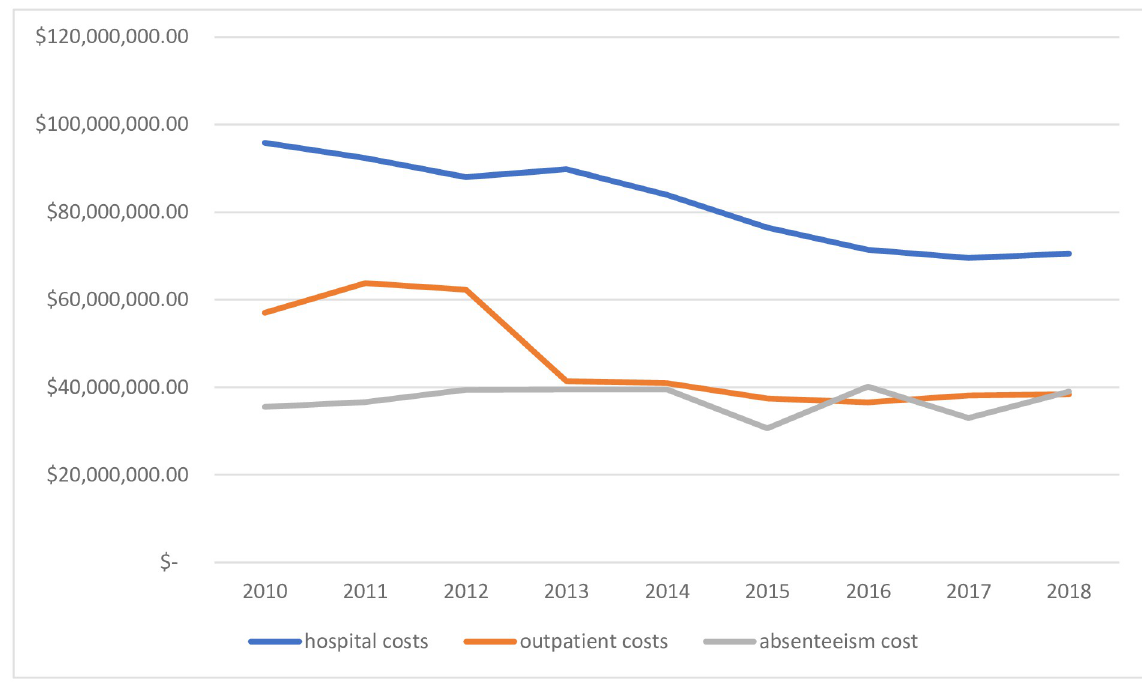
Fig 1. Evolution of total cost attributable to alcohol per year, by type of cost Brazil, 2010 to 2018.